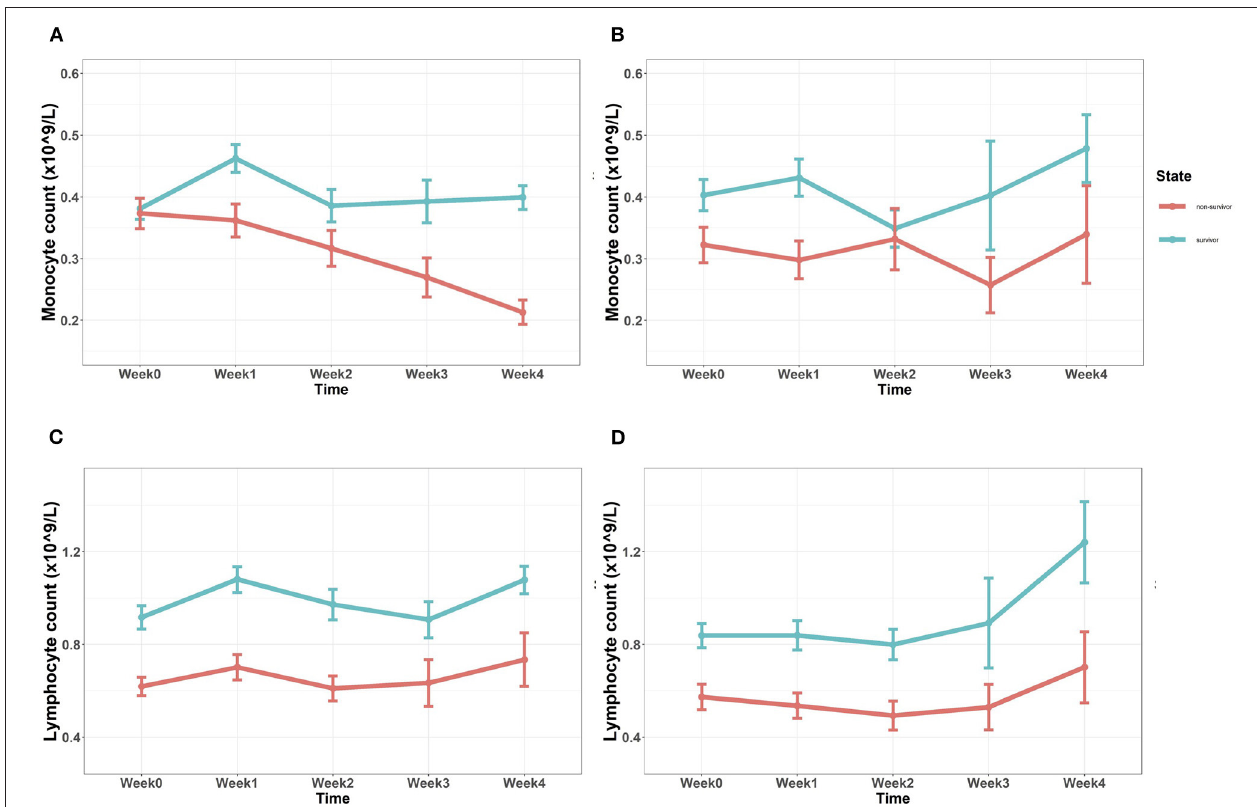
FIGURE 1 | (A,B) Tendency of absolute monocyte count after admission in the discovery cohort (A) and the validation cohort (B) . Baseline monocyte counts showed no significant differences, while monocyte count of the non-survivor group in the subsequent 4 weeks was significantly lower ( p < 0.05). (C,D) Tendency of absolute lymphocyte count after admission in the discovery cohort (C) and the validation cohort (D) . Absolute lymphocyte count of the non-survivor group in both the cohorts was continuously lower since admission ( p < 0.05) (Mann–Whitney U test).